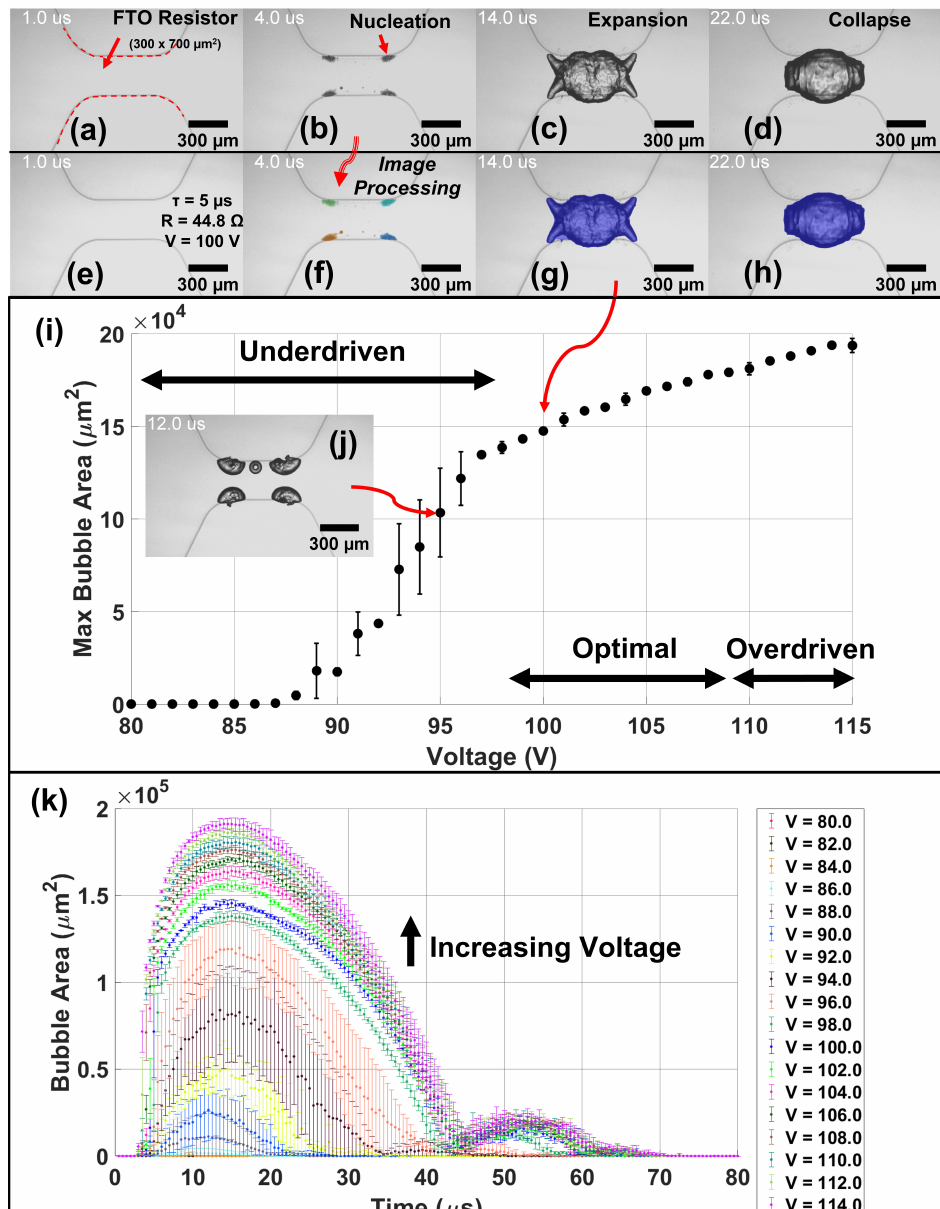
Figure 9. Open Reservoir Femtosecond Resistor Characterization Inter-Device Reproducibility — illustrates the effect of voltage on the maximum bubble area for a 300 × 700 µ m 2 FTO (8 Ω /sq) resistor in water with a 250 µ m fillet and firing parameters as follows: pulse duration ( τ ) = 5 µ s, firing frequency (f) = 10 Hz, and resistance (R) = 44.8 Ω . ( a – d ) Show the bubble evolution over time in which ( e – h ) show the calculation of bubble area using background subtraction image processing. ( i ) Depicts the maximum bubble area as a function of applied voltage with inset ( j ) showing the maximum bubble area at t = 12 µ s for V = 95 V. ( k ) Illustrates the full time history of the bubble area during expansion, collapse, and rebound phases as a function of voltage. Stroboscopic imaging was performed using a 1 µ s exposure (“shutter”) time with a 500 ns light pulse for an effective 2 Mfps frame rate. N = 3 sample replicates were performed for each voltage level in which each sample is a different